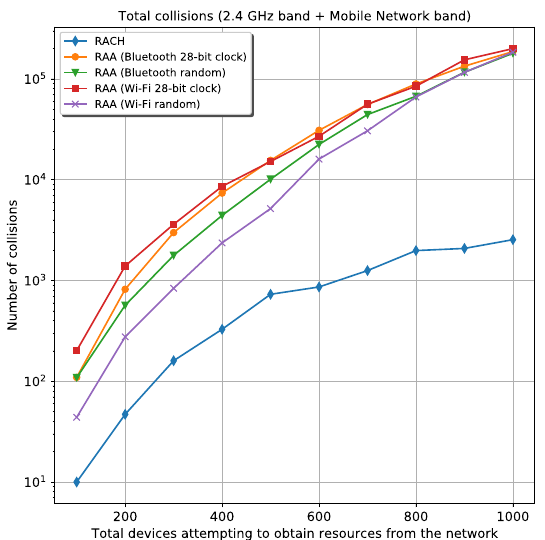
Figure 5. Total number of collisions in all bands for the classic Random-Access Channel (RACH) procedure and four di ff erent Random-Access Accelerator (RAA)